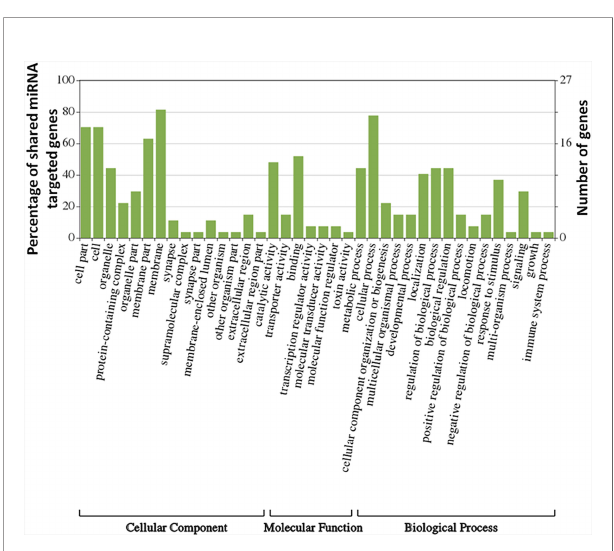
FIGURE 8 | Gene ontology (GO)-derived biological processes related to genes targeted by upregulated/downregulated miRNAs in female V. destructor